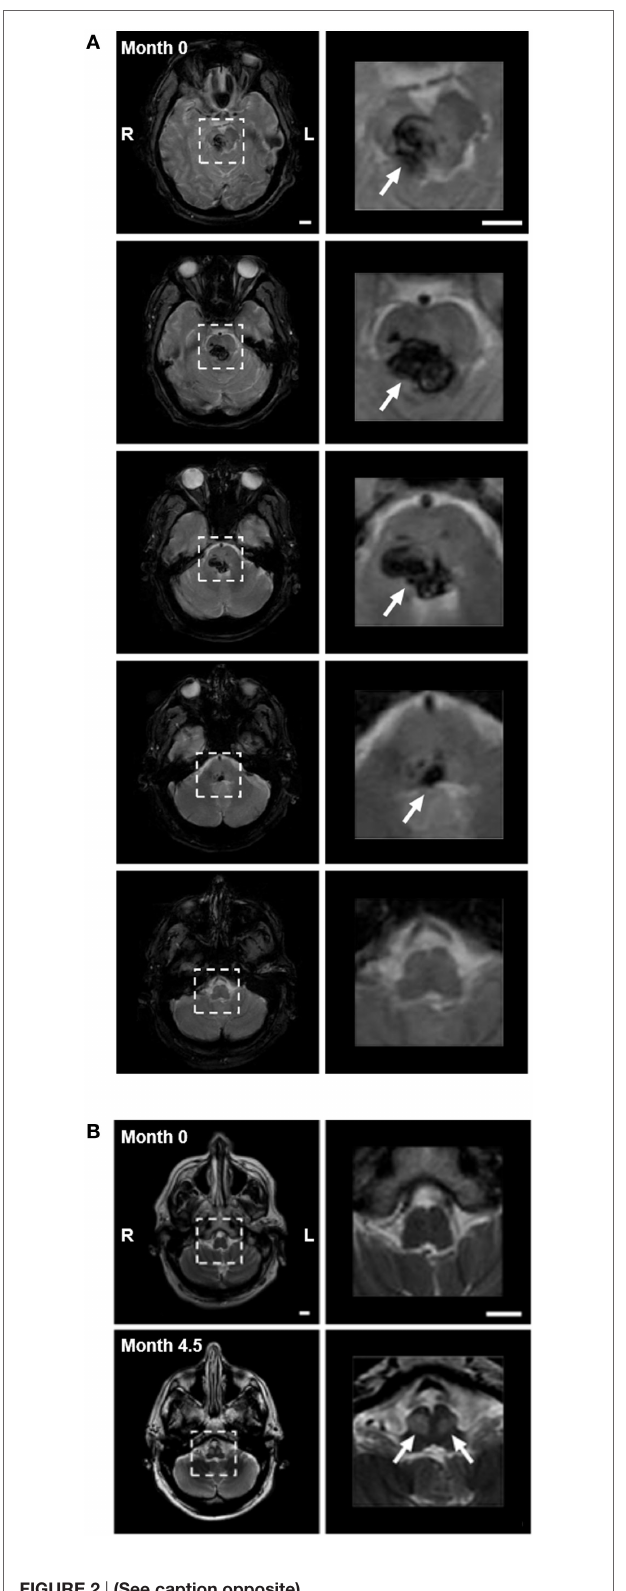
FIGURe 2 | Continued (a) Pontine hemorrhage imaged with gradient echo T2-weighted magnetic resonance imaging (MRI) within 24 h of hemorrhage. Left panels show consecutive 5-mm axial slices through the brainstem. Dashed squares highlight the region of hemorrhage. Right panels show 3.5 × magnification of the highlighted region, with arrows indicating the hemorrhage (dark). The hemorrhage involved the pons and midbrain but not the medulla, primarily on the right side. (B) Axial images with turbo-spin echo T2-weighted MRI of medulla at time of hemorrhage (month 0—top panels), and after 4.5 months (month 4.5—bottom panels). Top panels: low (left) and higher (right) magnification images through the medulla (highlighted with dashed box) showed no evidence of hyperintensity at the time of hemorrhage. Bottom panels: bilateral focal hyperintensity of the anterior medulla at the level of the inferior olivary nucleus (arrows) was present at month 4.5, indicating the presence of hypertrophy. Scale bars = 1